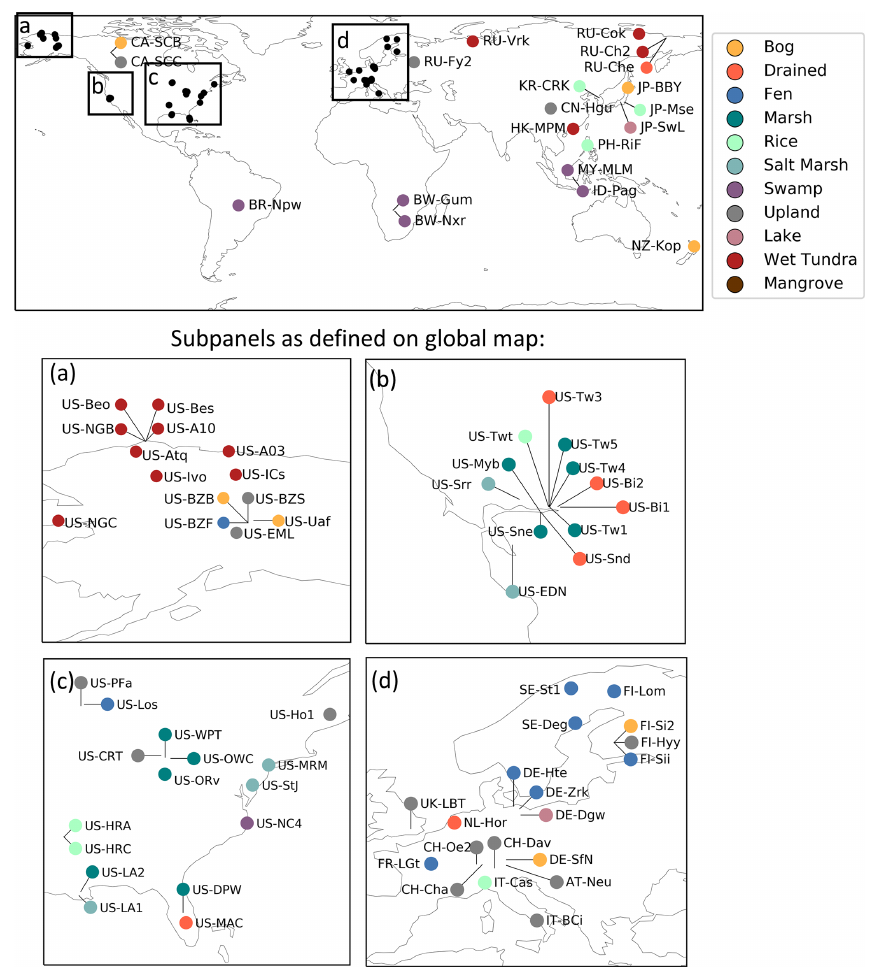
Figure 3. Global map of FLUXNET-CH 4 Version 1.0 site locations colored by site type. Panels (a) – (d) show sites that were too closely located to distinguish in the global